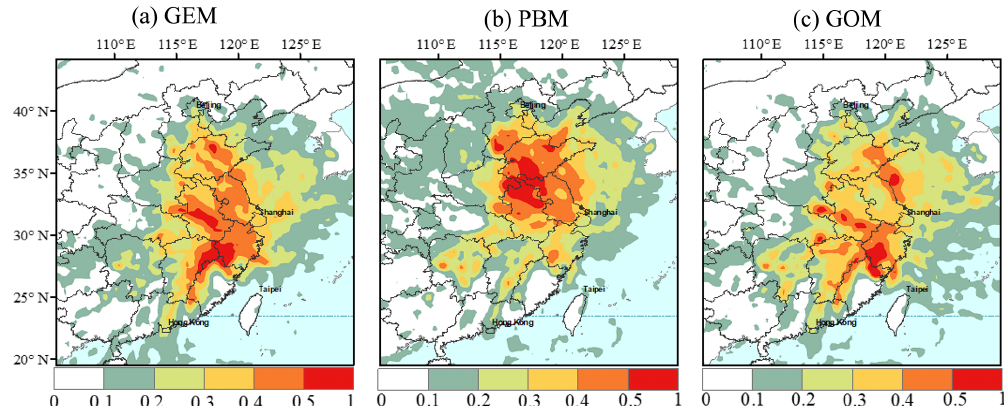
Figure 7. Potential source regions of atmospheric Hg (GEM, PBM, and GOM) at the observational site according to PSCF